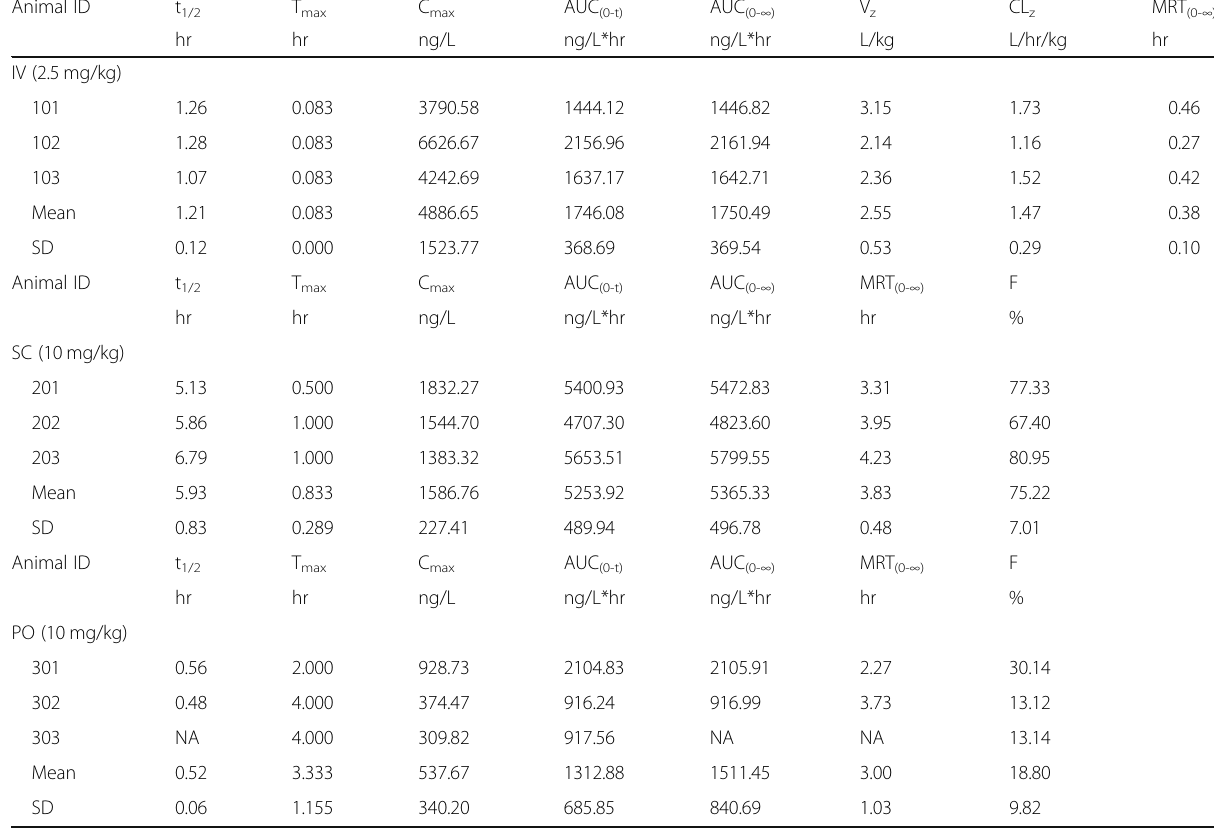
Table 1 Comparison of PK of DN052 with different dosing routes in rats Animal